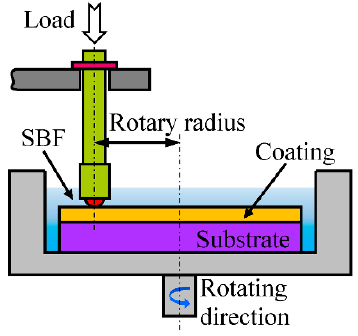
Figure 2. Schematic diagram of friction and wear test. Table 2. Experimental parameters of wear test.